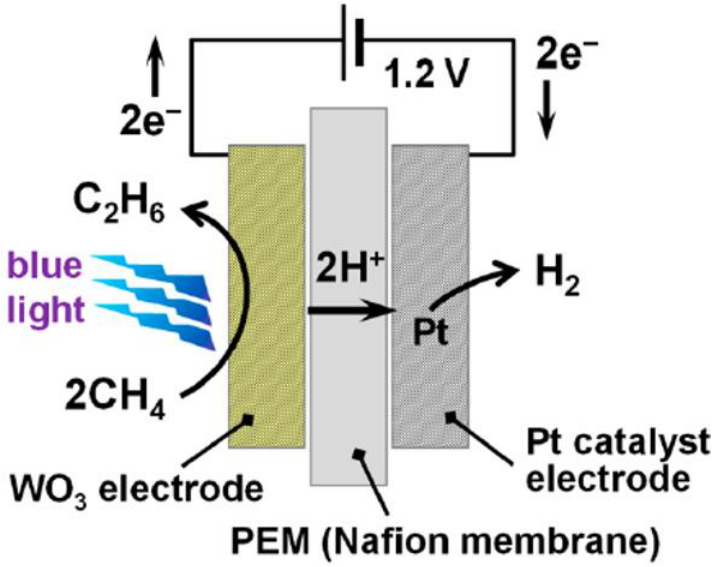
Figure 5. Membrane electrode assembly for PEC CH 4 activation [14] . Copyright 2019, American Chemical Society. Chemical